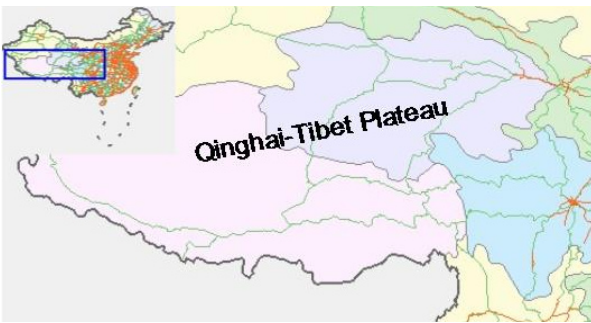
Fig. 1. Location of Qinghai-Tibet Plateau in the map of